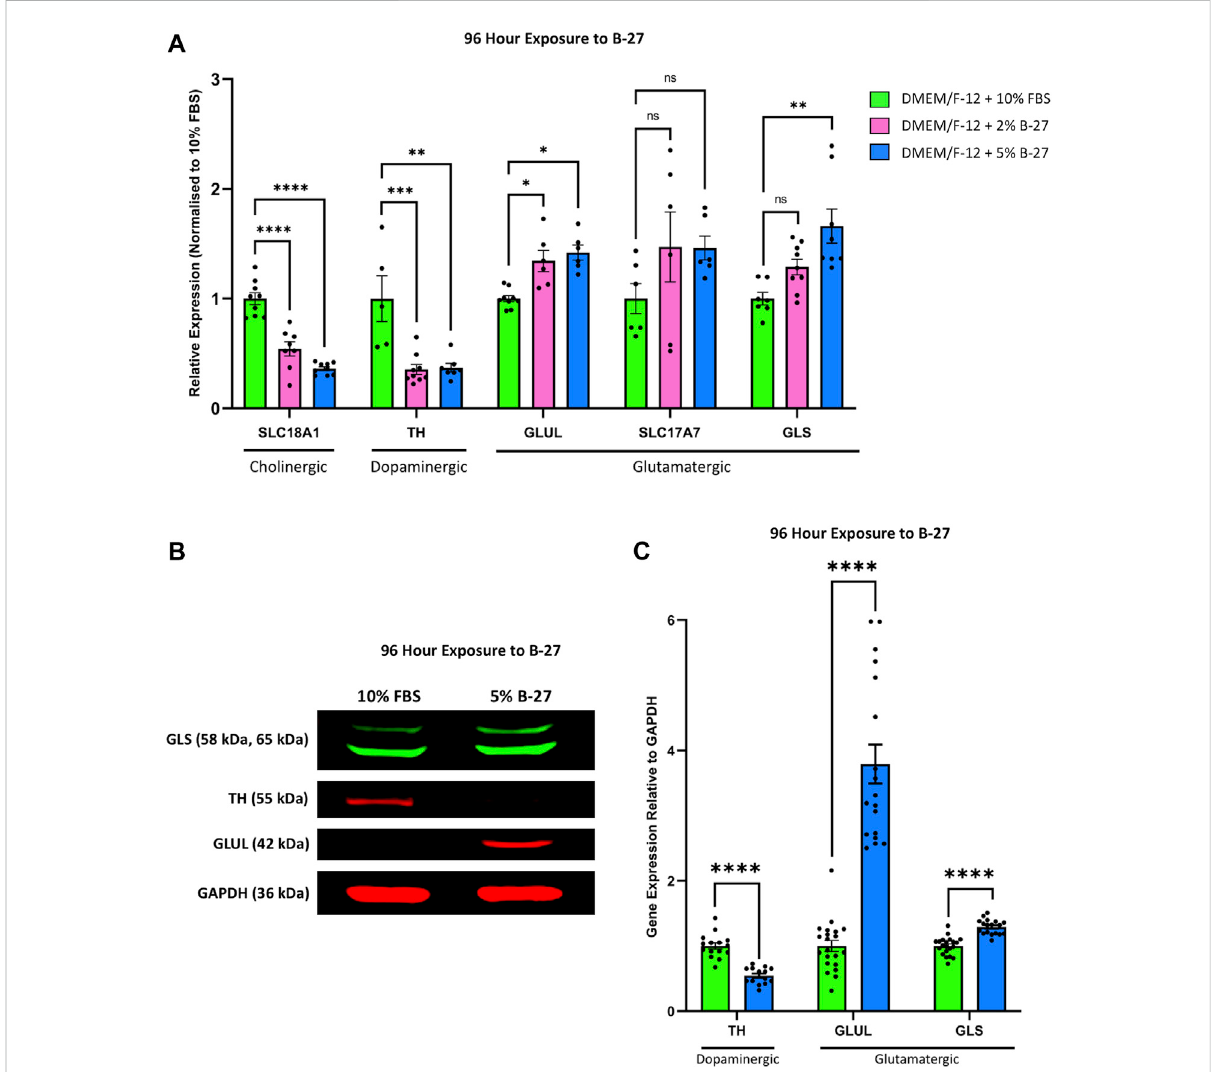
FIGURE 8 SH-SY5Ycellsdifferentiateintoamoreglutamatergic-likephenotypefollowingtreatmentwithB-27. (A) SH-SY5YcellswereculturedinDMEM/ F-12 supplemented with either 10% FBS, 2% B-27 or 5% B-27 for 96 h. qRT-PCR was performed to measure mRNA expressionof cholinergic marker SLC18A1 (VMAT1),dopaminergicmarker TH andglutamatergicmarkers GLUL , SLC17A7 (VGLUT1)and GLS .Relativeexpressionof SLC18A1,TH,GLUL, SLC17A7 and GLS (standardizedto GAPDH and POLR2A )normalizedtotheDMEM/F-12+10%FBScultureconditions.Datapresentedasmean± SEM; N = 3 independent biological samples with two to three technical replicates each. Statistical signi fi cance was determined using ordinary one- way ANOVA and Tukey ’ s multiple comparison tests in GraphPad Prism version 9.0.0 for Mac, GraphPad Software, San Diego, California, United States, www.graphpad.com. ns = not signi fi cant; * p < 0.05; ** p < 0.01; *** p < 1 × 10 – 3 ; **** p < 1 × 10 – 4 . (B) Western blot of lysate from SH- SY5YcellsculturedinDMEM/F-12supplementedwitheither10%FBSor5%B-27for96h.Membraneswereprobedwithrabbitanti-GLS( Proteintech #29519-1-AP), mouse anti-TH ( Proteintech , #66334-1-Ig), mouse anti-GLUL ( Proteintech , #66323-1-Ig) and mouse anti-GAPDH ( Santa Cruz Biotechnology ,#sc-47724).GAPDHwasusedasaloadingcontrol.MolecularweightsareasfollowsGLS=58 kDaand65 kDa;TH=55 kDa;GLUL= 42 kDa; GAPDH = 36 kDa. (C) Levels of protein expression relative to GAPDH were quantify through densitometric analysis using the FIJI software (Schindelinetal.,2012).Threeindependentexperimentswereperformedanddensitometricanalysisperformedusingsevenindependentblots.Data presented as mean ± SEM. Statistical signi fi cance against the DMEM/F-12 + 10% FBS condition was determined using Unpaired t tests in GraphPad Prismversion9.0.0forMac,GraphPadSoftware,SanDiego,California, UnitedStates,www.graphpad.com.**** p < 1×10 – 4 .DMEM/F-12,Dulbecco ’ s modi fi ed eagle medium/nutrient mixture F-12 with GlutaMAX supplement; FBS, fetal bovine serum; GAPDH, Glyceraldehyde-3-phosphate dehydrogenase ; GLS, Glutaminase ; GLUL, Glutamate-ammonia ligase ; mRNA: messenger RNA; POLR2A, RNA polymerase II subunit A ; SEM, standard error of the mean; SLC17A7, Solute carrier family 17 member 7 ; SLC18A1, Solute carrier family 18 member A1; TH, tyrosine hydroxylase ; VGLUT1, vesicular glutamate transporter 1 ; VMAT1, Vesicular monoamine transporter 1